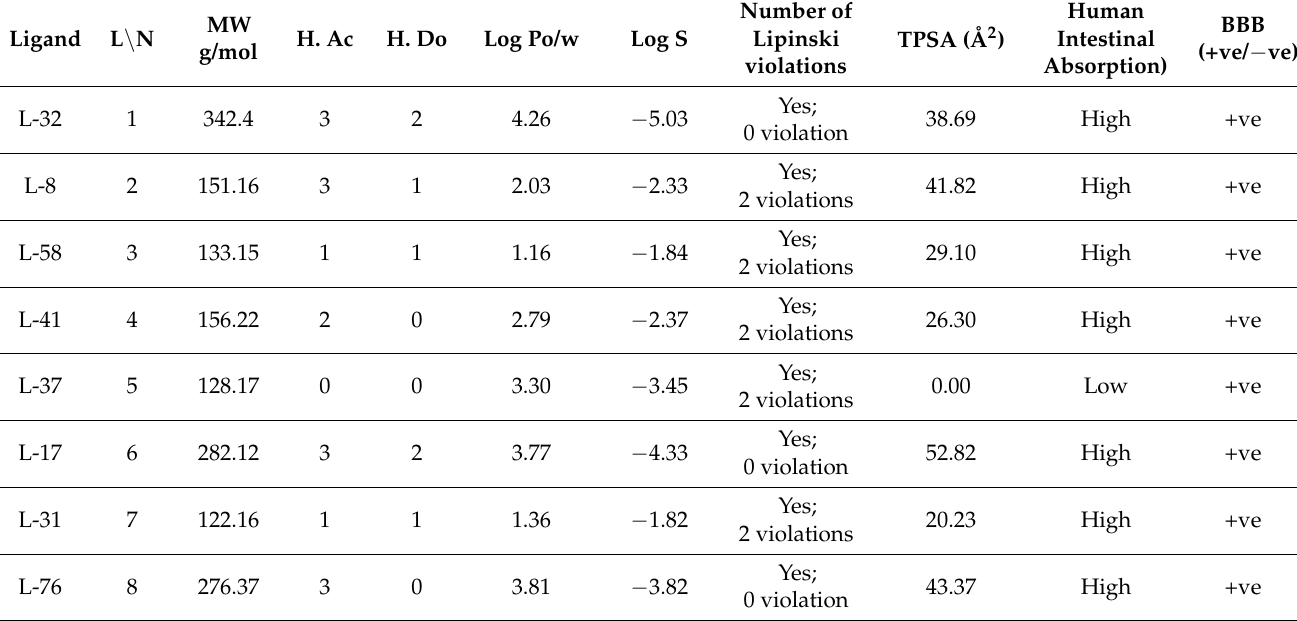
Table 5. Pharmacological assessment of the screened hit ligand molecules. Here, Ac indicates hydrogen bond acceptor; H. Do indicates hydrogen bond donor; TPSA indicates topological polar surface area; BBB indicates blood–brain